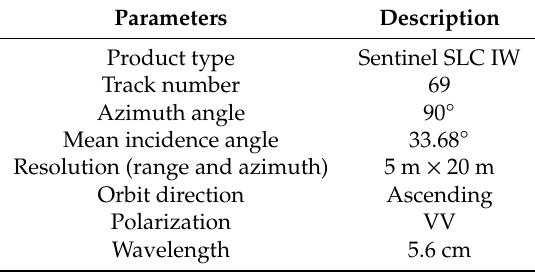
Table 1. Particular parameters of Sentinel-1A terrain observation by progressive scan (TOPS) data used in the